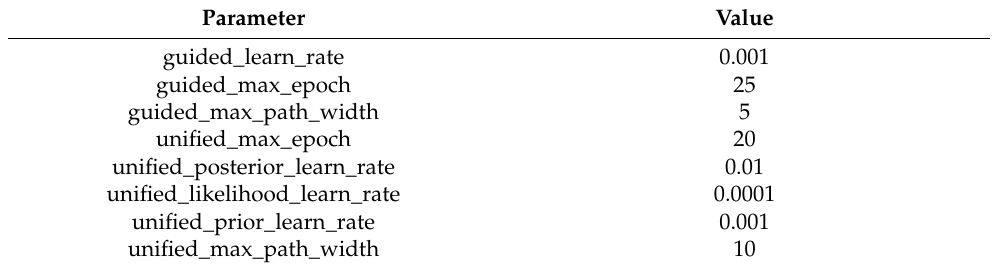
Table 3. Training parameters.